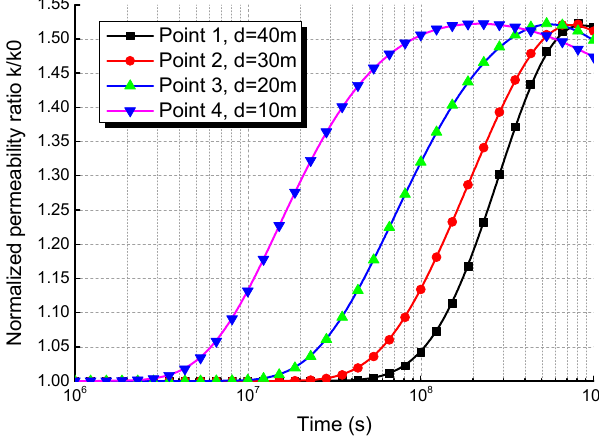
Figure 8. Evolution of coal permeability at different observation sites.